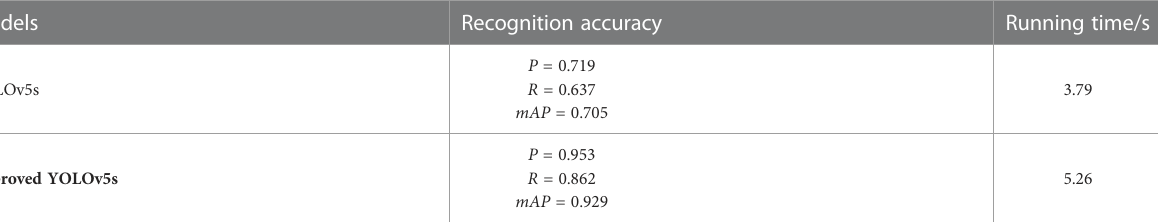
TABLE 3 Detection results of improved YOLOv5s model test on the test dataset. Models